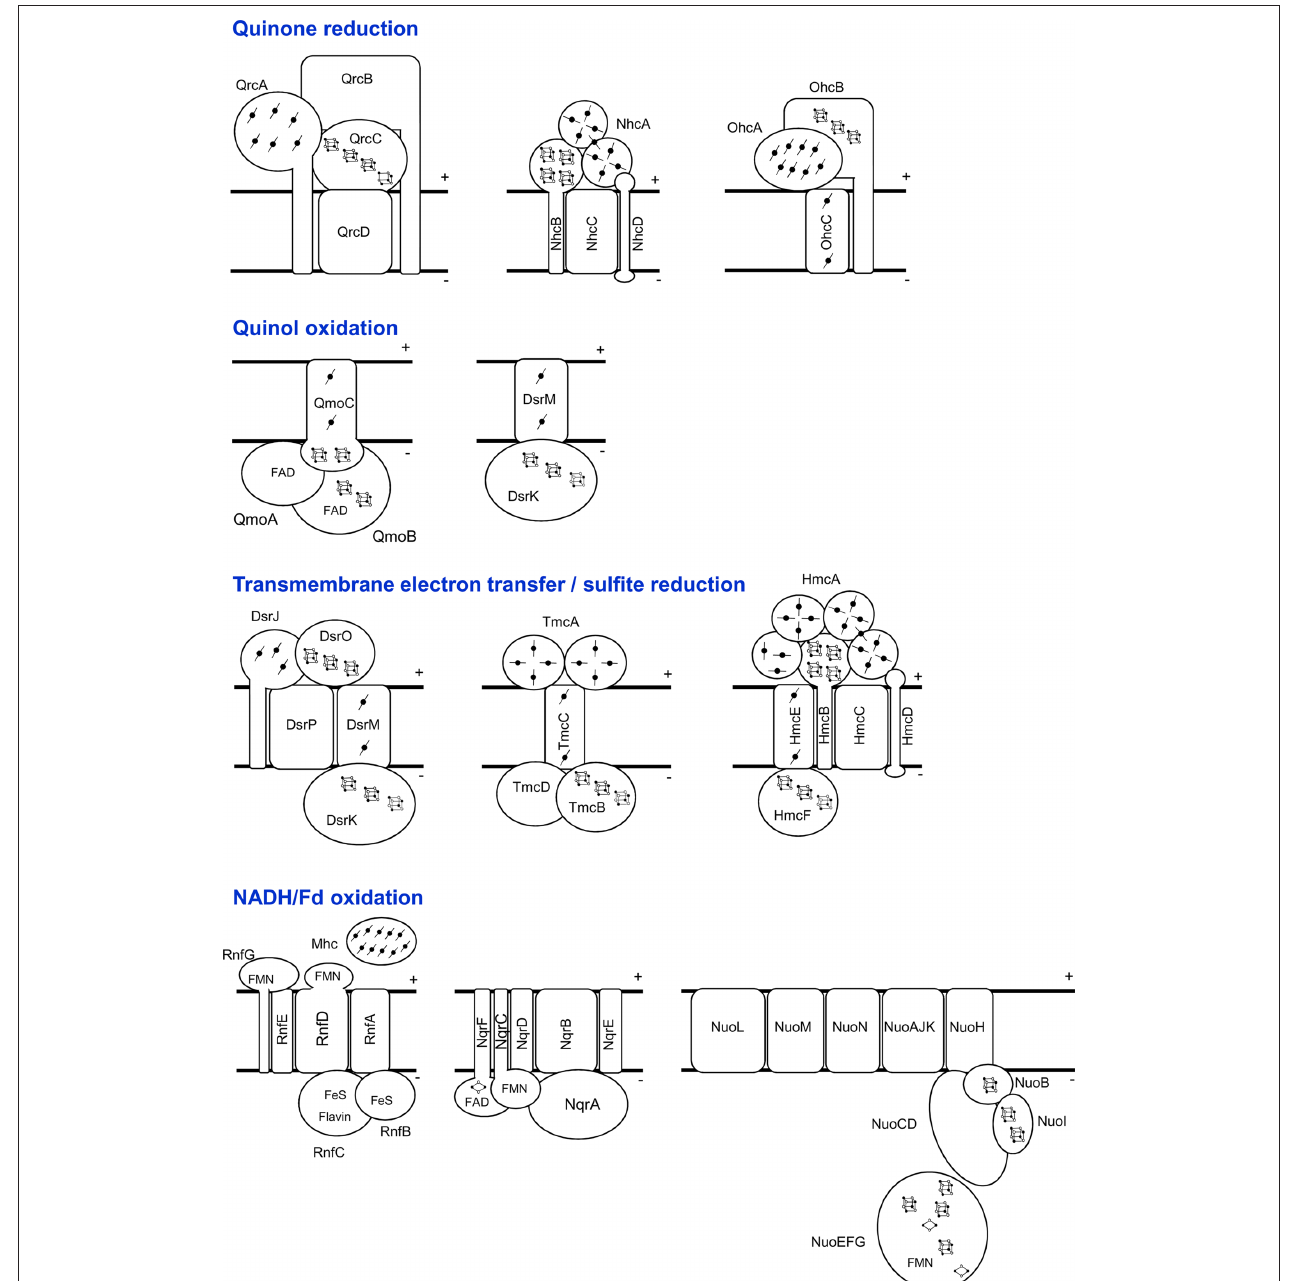
FiguRE 2 | Schematic representation of the SRO membrane-bound electron-transfer complexes, grouped in different categories according to expected function. The NuoEFG proteins are shown as one module, which is not